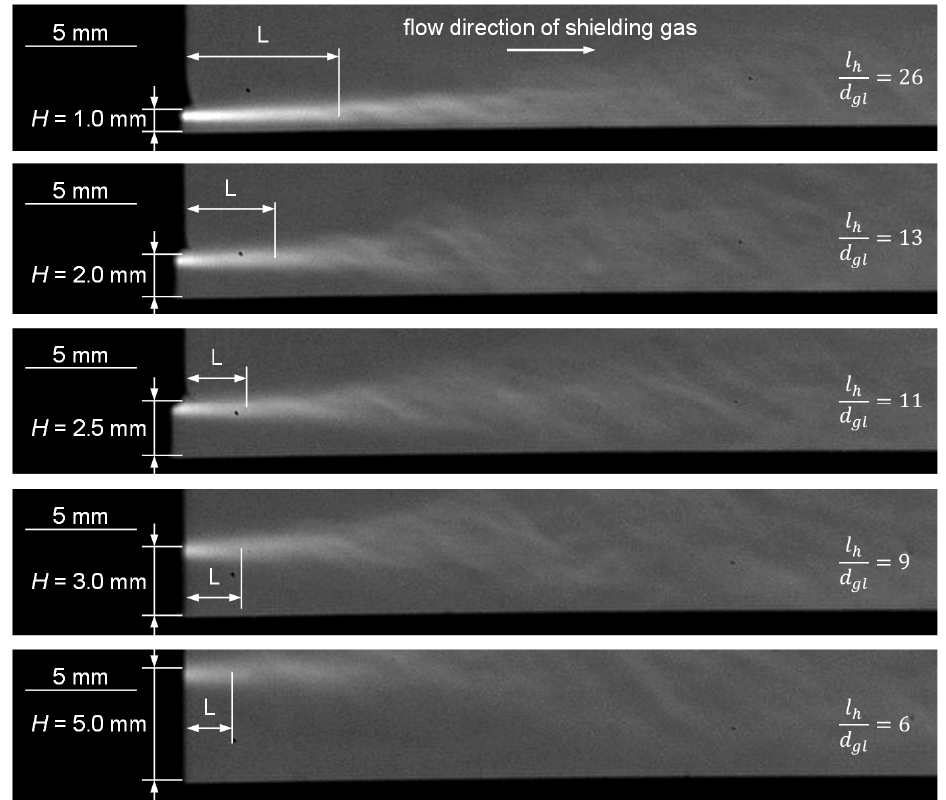
Figure 7. Dependance of laminar flow length on adjustable heights H and ratio l h /d gl . It should be noted that the brighter the area in the Schlieren images, the higher the density gradient at this position. Close behind the nozzle, a small area of the shielding gas is contaminated with atmosphere. With increasing outflow length, this area grows and the contrast decreases. The flow is in a quasi-stationary state, only the formation of turbulent structures causes time-dependent fluctuations. In the transition region from laminar to turbulent flow, a continuous change between both conditions occurs. This intermittency of turbulence is typical for the transition region [21]. The chosen procedure ( l h = const. , H = var. ) also varies the ratio between l h to d gl (see Equation (4)). Therefore, different heights H also provide information on the effect of the reached parabolic flow. The measured length of the laminar flow is indicated as L in every picture and decreases for increasing heights H because a less parabolic velocity profile is achieved based on the same inlet length. At the same time, with increasing height H , the area covered by shielding gas increases before turbulences reach the metal surface—even if the length of laminar flow is